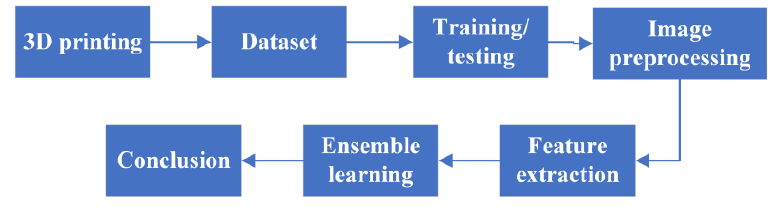
Figure 3. Experimental procedure.